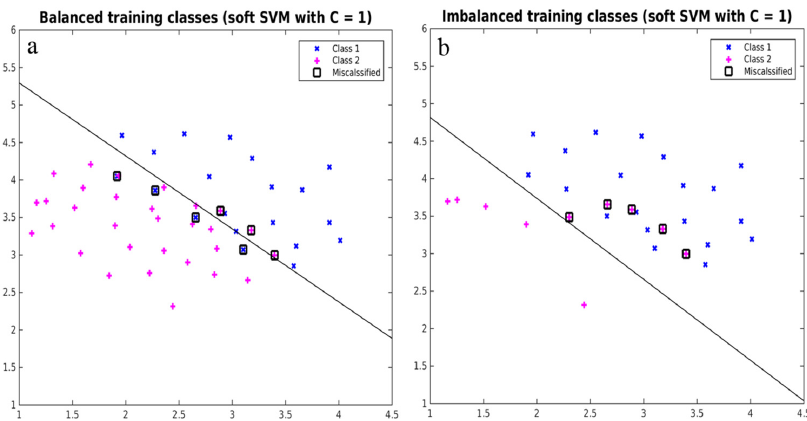
Figure 2. Effect of imbalanced data on SVM decision plane. ( a ) Visualization of the SVM decision plane when two classes are of balanced size; ( b ) the decision plane when data size is imbalanced with a large number of misclassifications of the minority class.